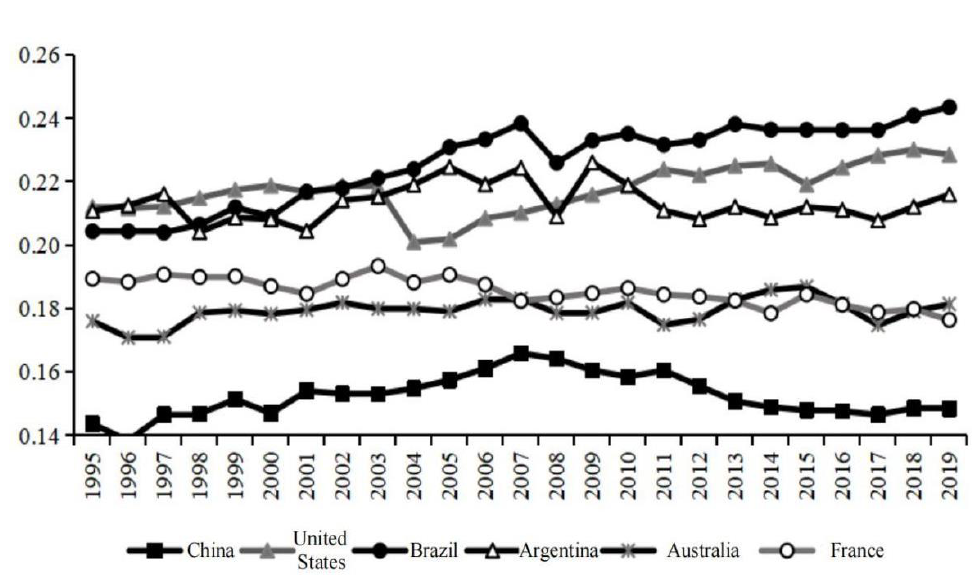
Figure 2. Comparison of the coupling coordination degree of the subsystems of the beef cattle industry in different countries from 1995 to 2019.